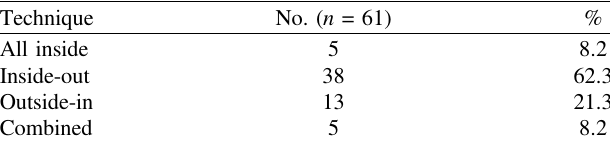
Table 1. Percentage of techniques used for meniscal